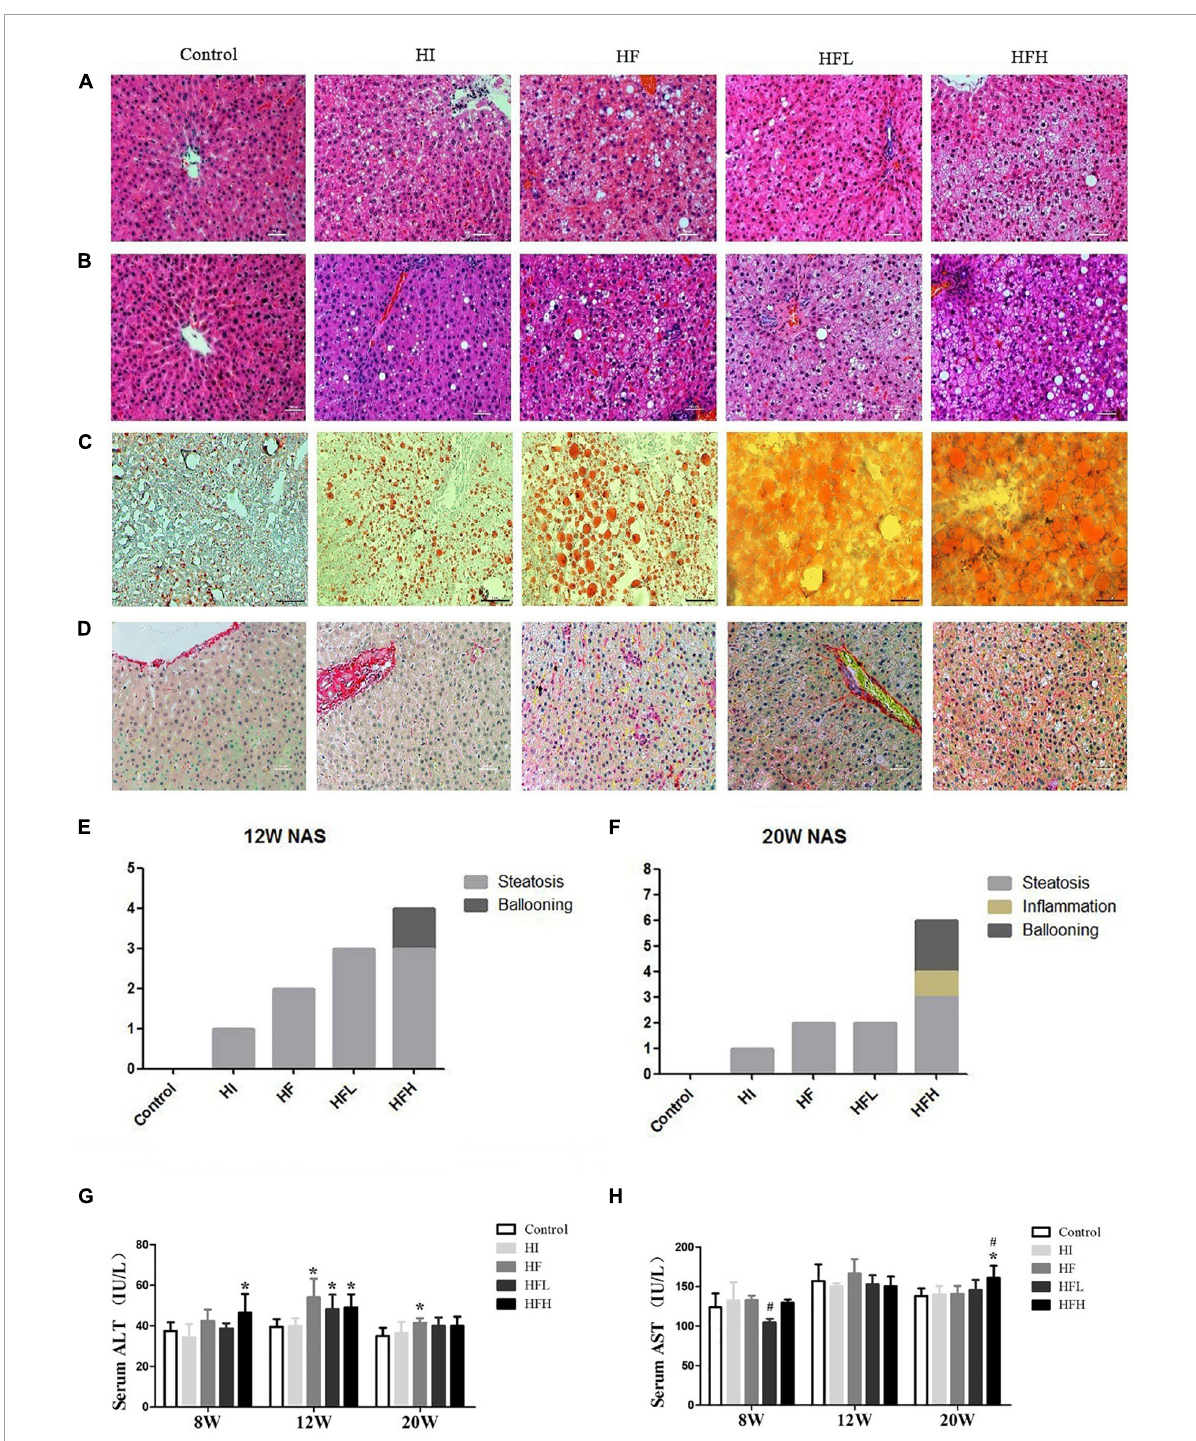
FIGURE2 Dietary iron overload aggravated hepatic steatosis and liver injury in rats with a HFD-induced NAFLD. HE staining at (A) 12 and (B) 20 weeks. (C) Oil red O staining at 20 weeks. (D) Sirius red staining at 20 weeks (magnification × 200). NAFLD activity scores in rats at (E) 12 and (F) 20 weeks. Serum (G) ALT and (H) AST levels in rats at each time point. * and # compared with control/high-fat group at the same time point, respectively, P < 0.05